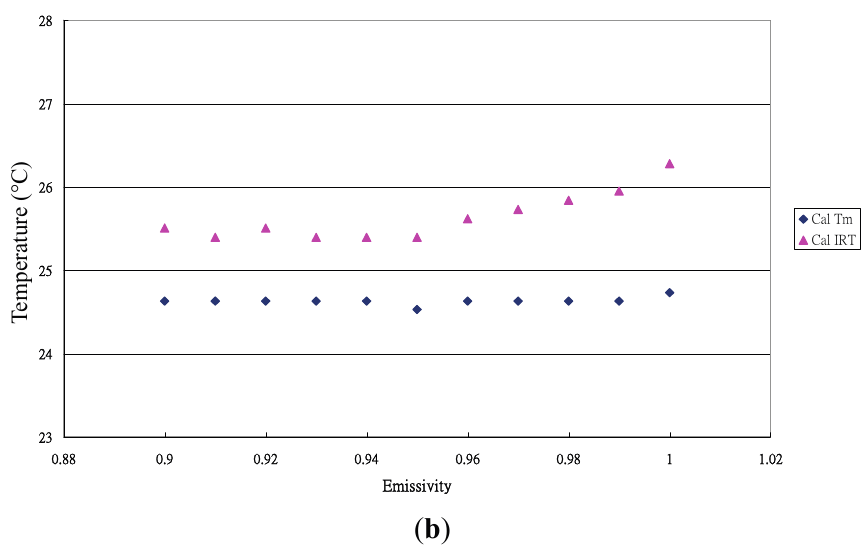
Figure 3. Typical distribution of the original and transformed measured data for Paphiopedilum leaves. ( a ) Original temperature data; ( b ) Transformed data.